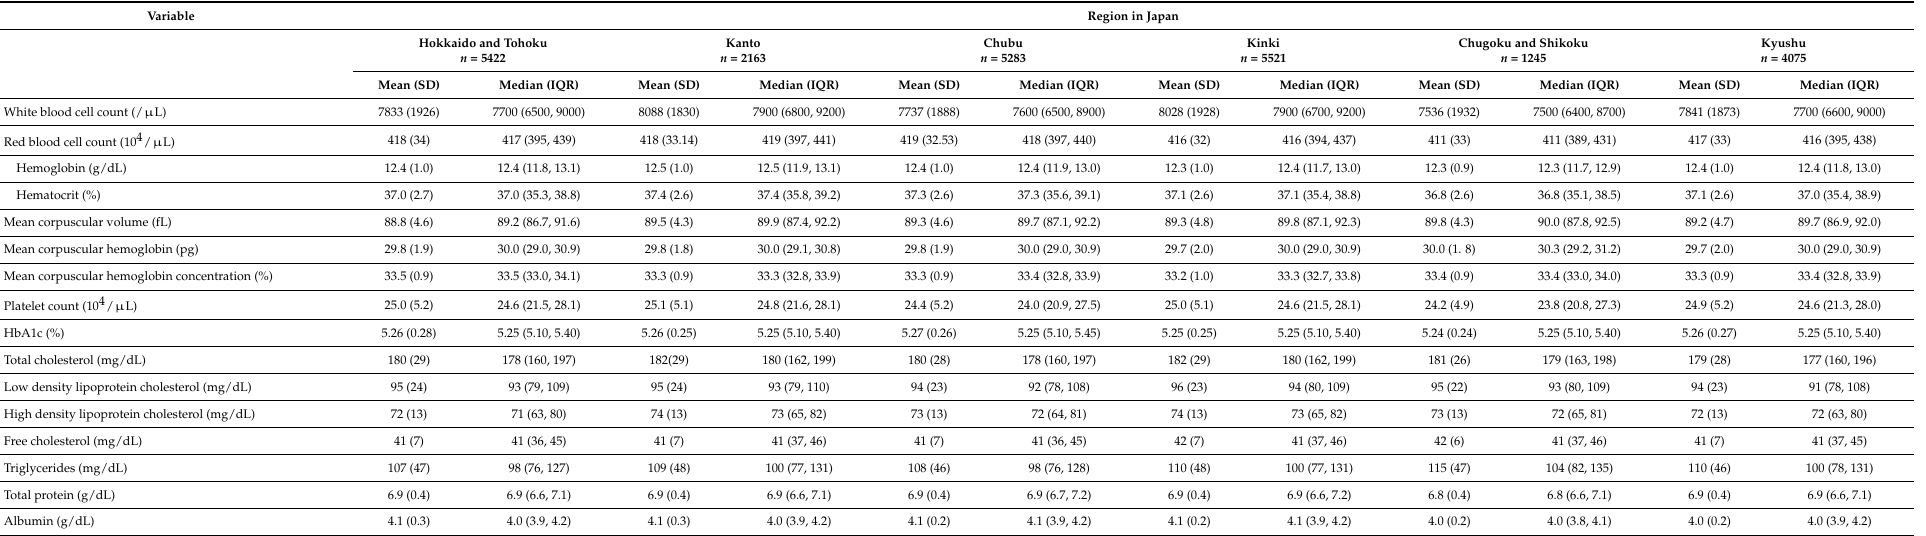
Data indicate mean (standard deviation) and median